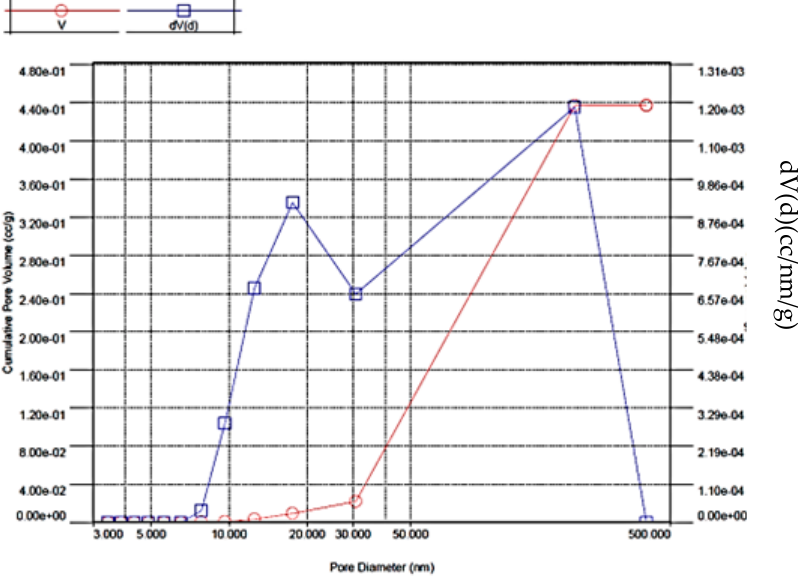
Figure 9. Example of BJH plots for zirconia sample ZrO2_PS1_60. Table 2. Surface area development, pore volumes, and pore diameters.